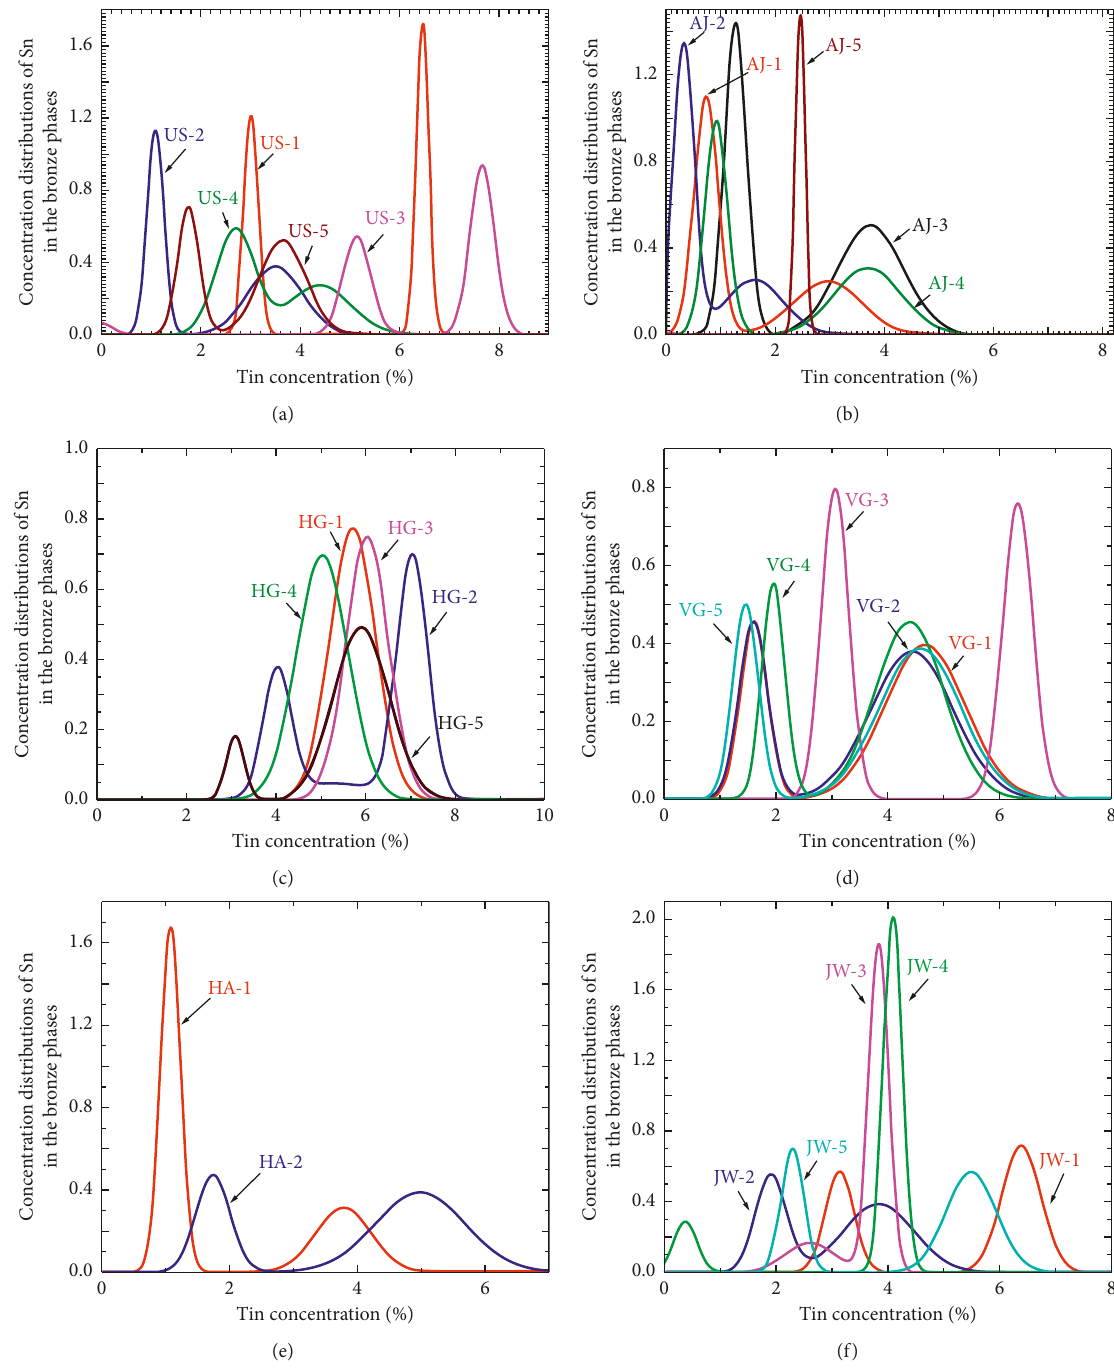
Figure 10: Distributions of Sn in the α -phases in six of the coins and flan types: (a) unstruck flans, no dates, (b) Alexander Jannaeus, 80/79 BCE, (c) Herod the Great ca. 27–22 BCE, (d) Valerius Gratus, 18/19 CE, (e) Herod Agrippa I 41/42 CE, and (f) Jewish War/Revolt 67/68 CE. The single JH-3 had a distribution very similar to HA-1, shifted slightly to a lower Sn